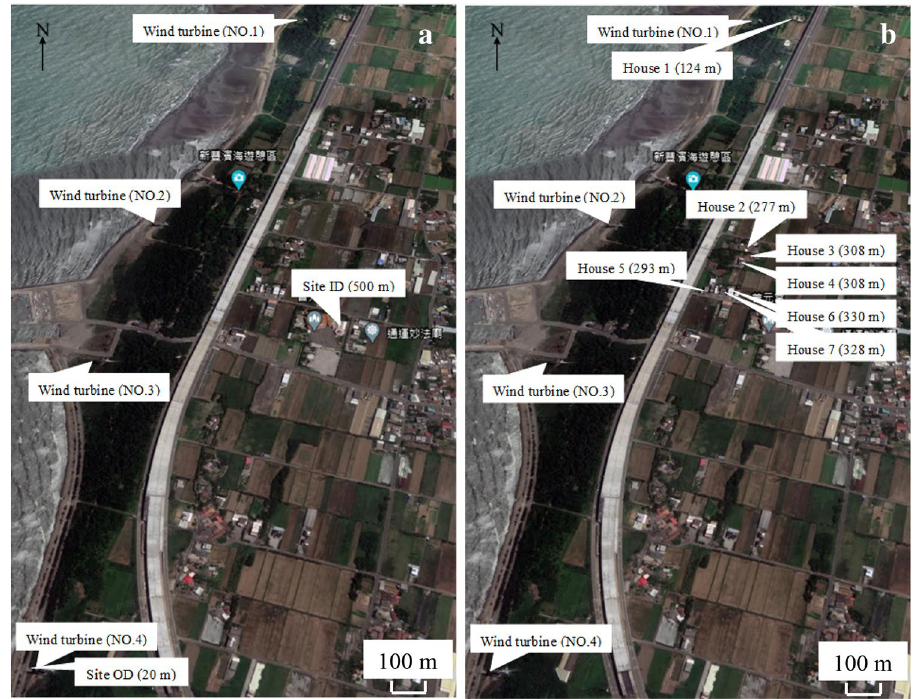
Figure 1. Schematics showing the locations of (a) field monitoring sites and (b) household monitoring residences relative to wind turbines 69